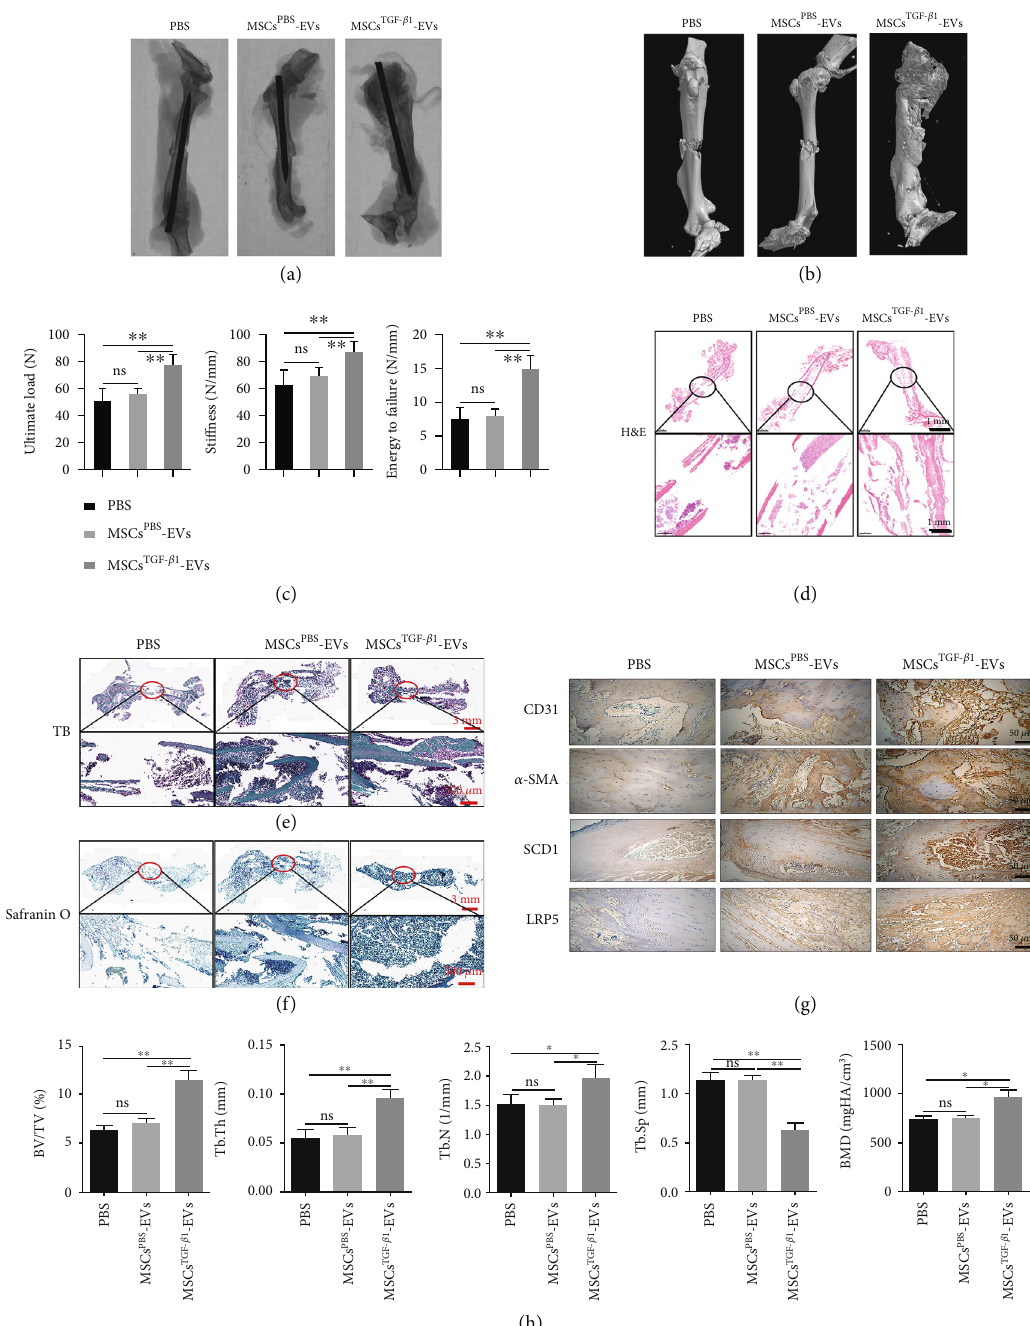
Figure 3: Transplanting MSC TGF- β 1 -EVs promotes bone fracture repair in mice. (a) Representative radiograph images of the femur fracture model in mice 21d postfracture from the PBS, MSC TGF- β 1 -EV, and MSC PBS -EV groups, n = 6 . (b) Representative 3D images from micro-CT scanning of the femur fracture model in mice on day 21 postfracture from the di ff erent groups, n = 6 . (c) Detection of changes in the ultimate load, sti ff ness, and energy to failure, n = 6 . (d – f) Results of H&E, TB, and Safranin O-Fast Green staining for the femur fracture model in mice on day 21 postfracture from the PBS-, MSC TGF- β 1 -EV-, and MSC PBS -EV-exposed groups, n = 5 . (g) Immunohistochemistry of CD31, α -SMA, SCD1, and LRP5 for the femur fracture model in mice 21d postfracture from the PBS-, MSC TGF- β 1 -EV-, and MSC PBS -EV-exposed groups, n = 6 . (h) Bone volume/tissue volume (BV/TV), trabecular number (Tb.N, mm − 1 ), trabecular thickness (Tb.Th, mm), trabecular spacing (Tb.Sp, mm), and bone mineral density (BMD) in the PBS-, MSC TGF- β 1 -EV-, and MSC PBS -EV-exposed groups at 21 d, n = 6 . Data are expressed as mean ± SD ; ∗ P < 0 : 05 and ∗∗ P < 0 : 01 . ns: no signi fi cance; MSCs: mesenchymal stem cells; EVs: extracellular